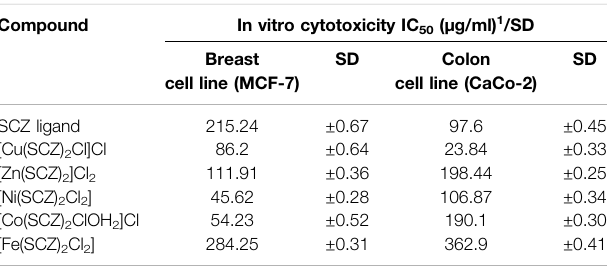
TABLE6| CytotoxicactivityofSCZanditsmetalcomplexesagainsthumantumor cells and SD values. Compound In vitro cytotoxicity IC 50 (µg/ml) 1